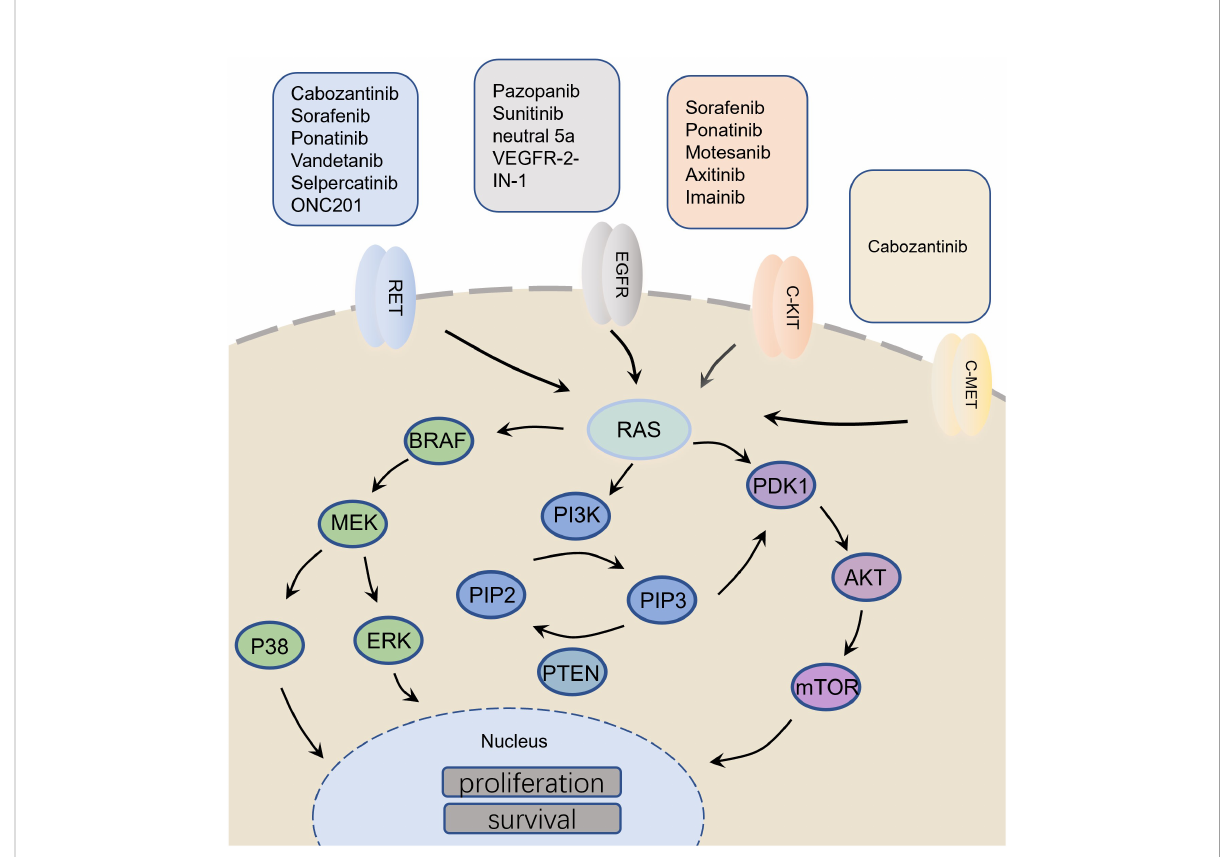
FIGURE 1 Molecular mechanism related to medullary thyroid carcinoma and its targeted